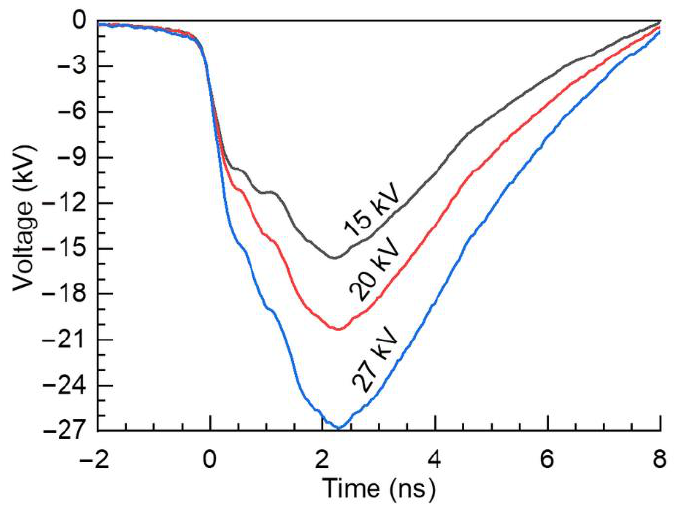
Figure 2. Voltage pulses U 0 of various amplitudes (16, 20, 27 kV) produced by an Antares GIN-100-1 generator at a matched load.